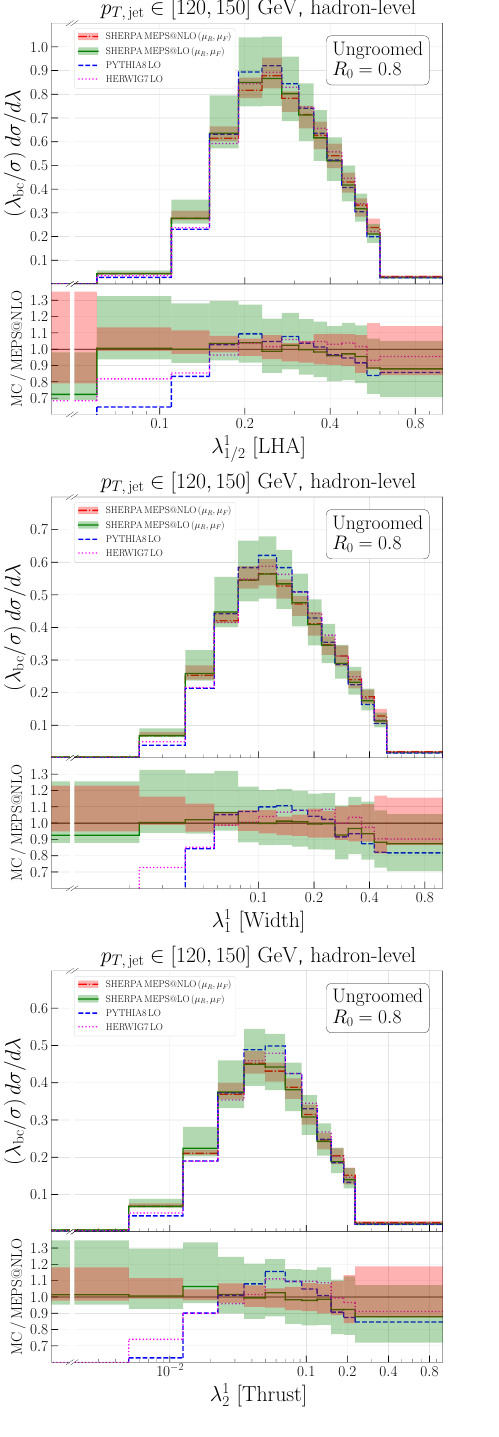
Figure 1 . Comparison of hadron-level predictions for ungroomed and groomed jet-angularities in Zj production from P YTHIA and H ERWIG (both based on the LO Zj matrix element), and MEPS@LO as well as MEPS@NLO results from S HERPA . Here p T, jet ∈ [120 , 150] GeV and λ bc stands for the bin